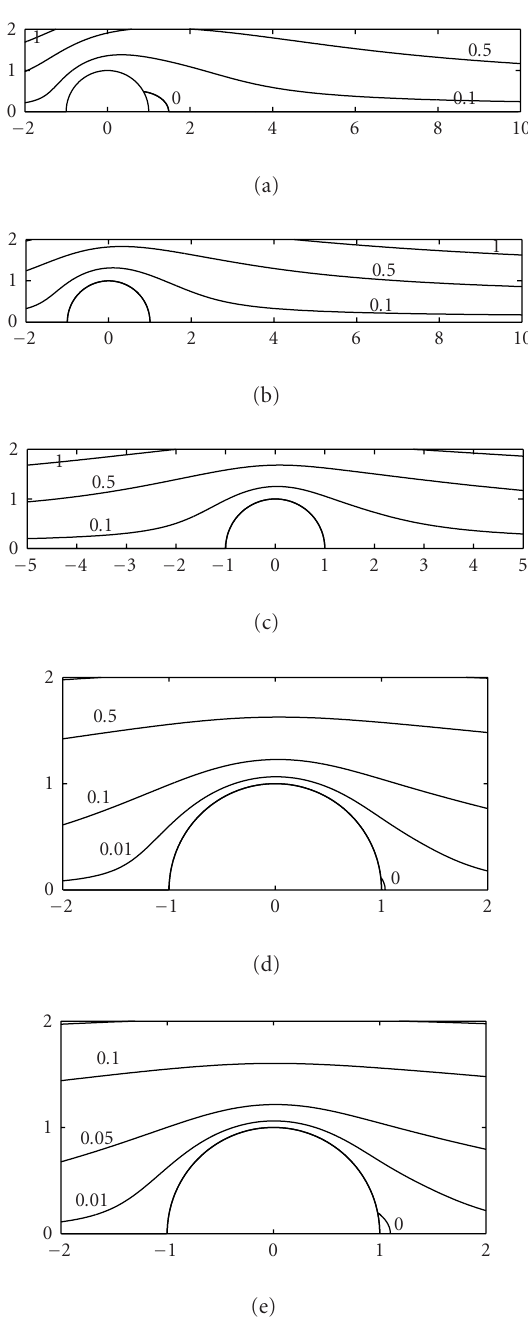
Figure 4.1 . Streamlines for Re = 10. (a) N = 0, (b) N = 1, (c) N = 5, (d) N = 10, and (e) N =